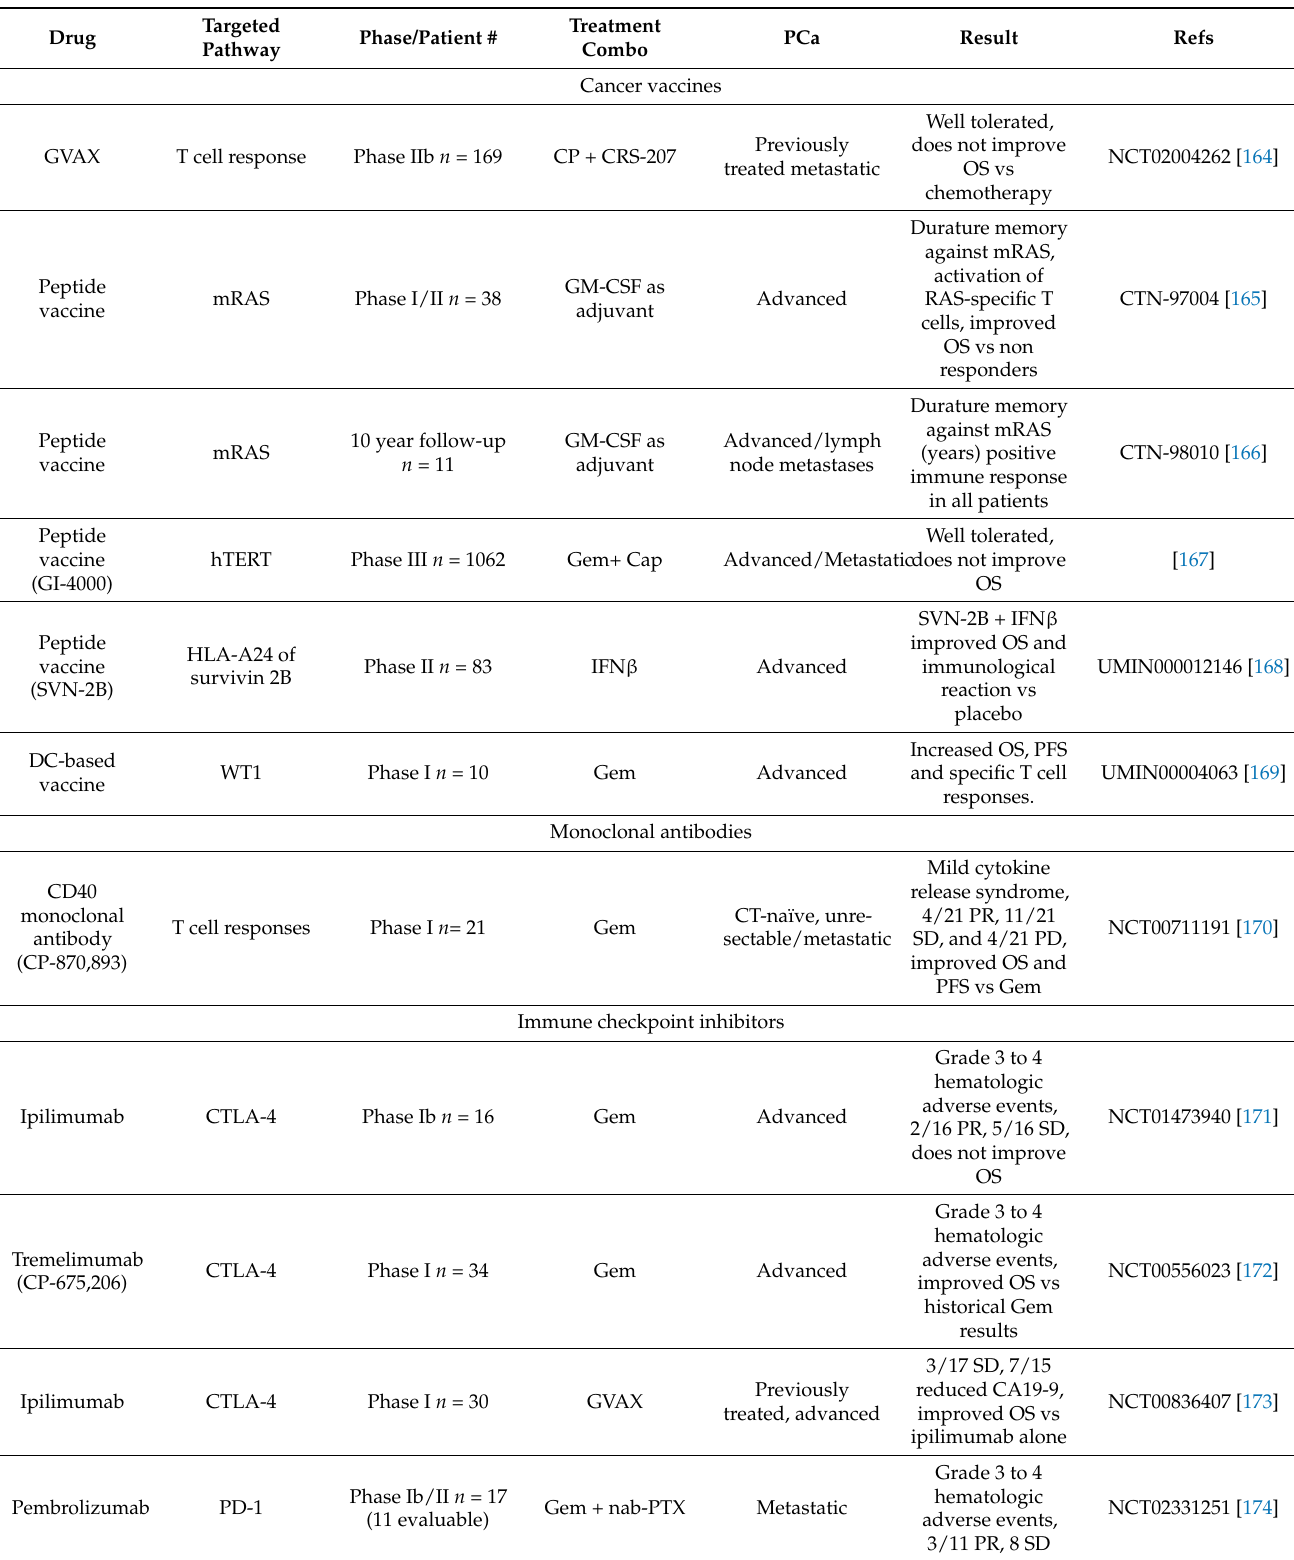
Table 2. Summary of clinical trials targeting immune regulatory